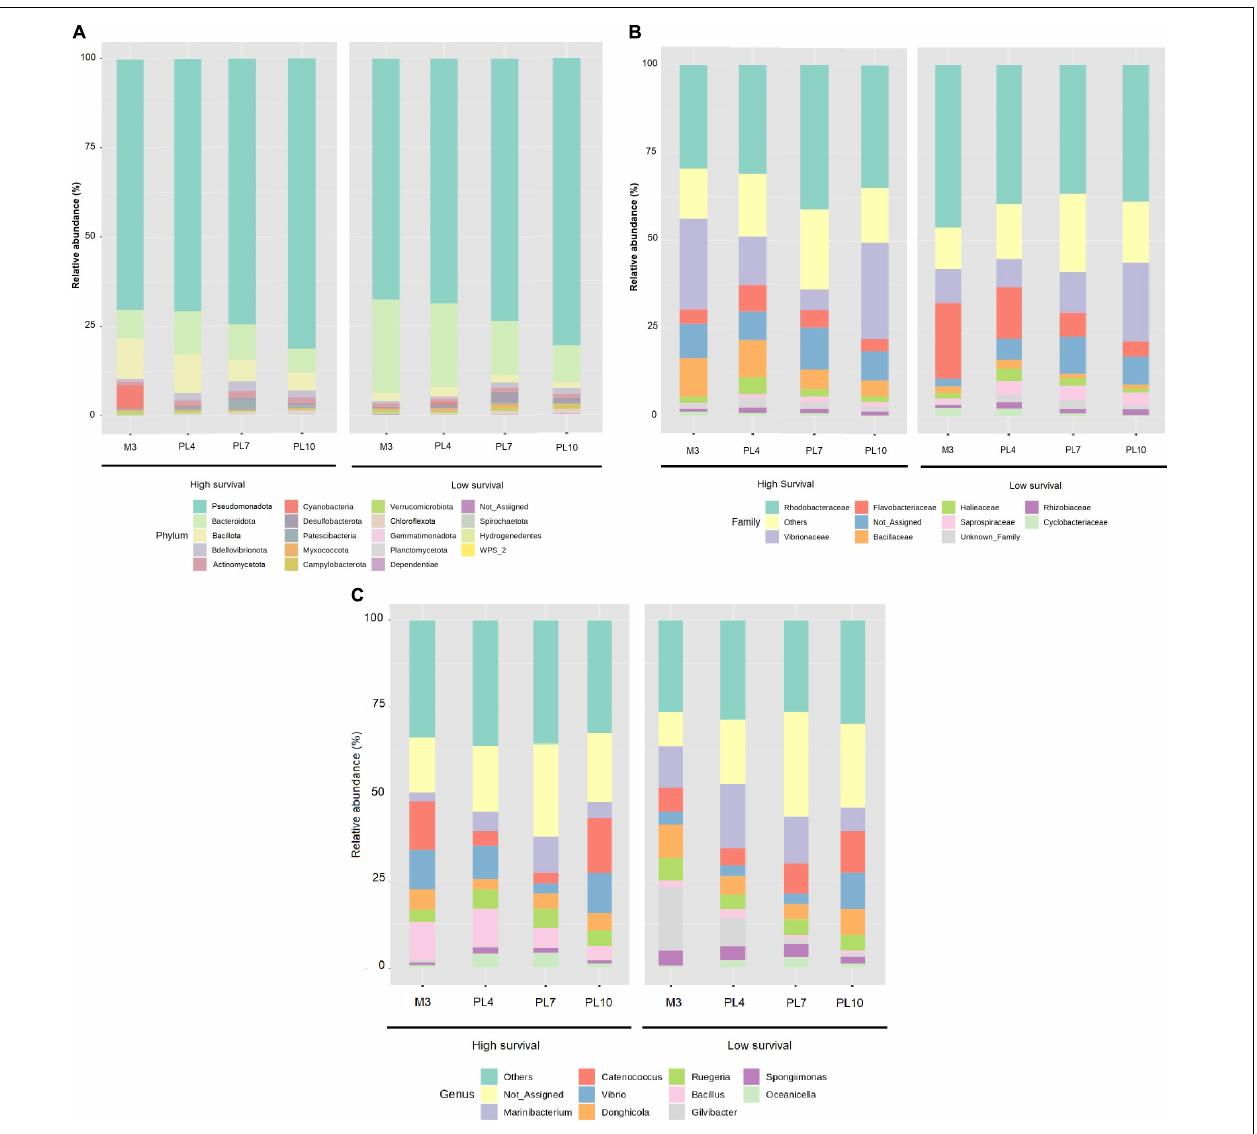
FIGURE 4 | Relative abundance of the larval microbiome in the high- and low-survival tanks affected with AHPND. (A) Phylum level. (B) Family level. (C) Genus level.